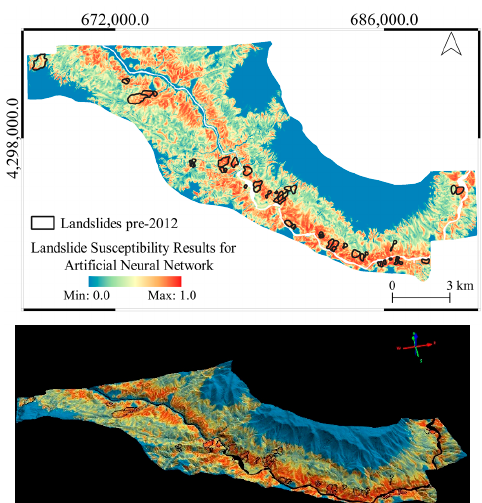
Figure 11. The landslide susceptibility map produced with the ANN method in 2D (above) and 3D (below) visualization.